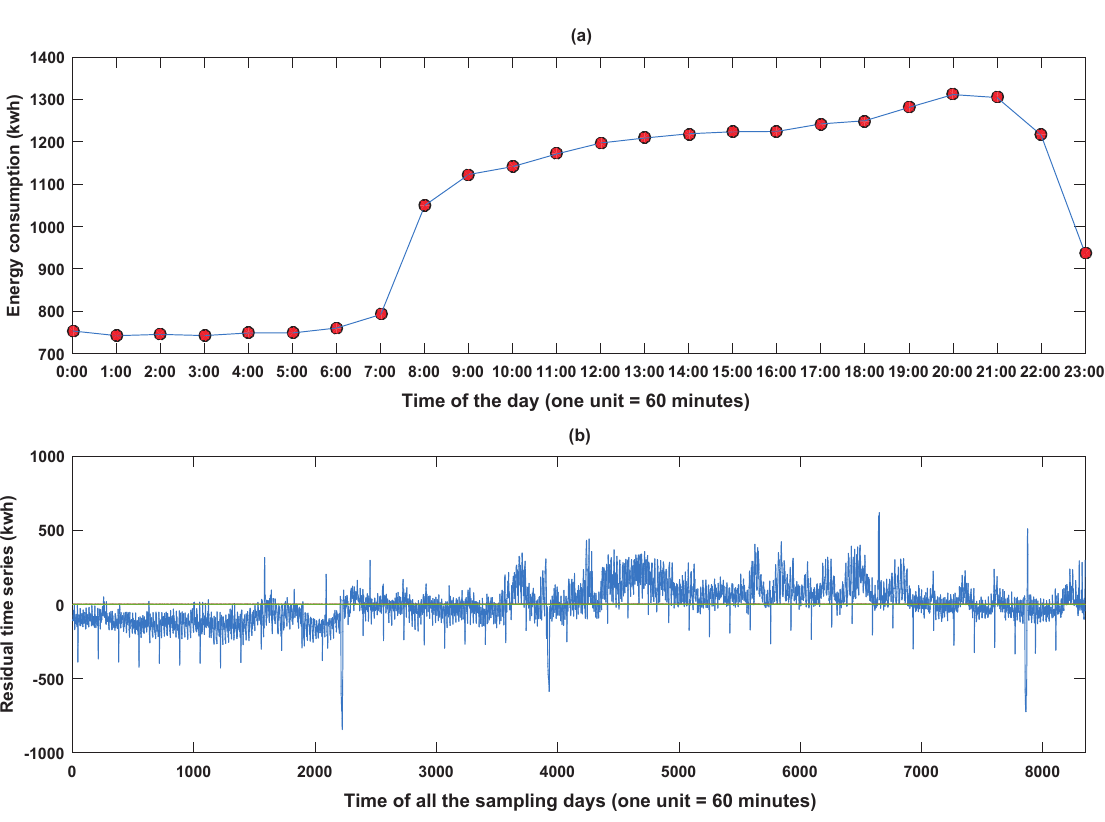
Figure 8. Periodicity knowledge and the residual time series of the retail store data set: ( a ) the daily-periodic energy-consuming pattern; ( b ) the residual time